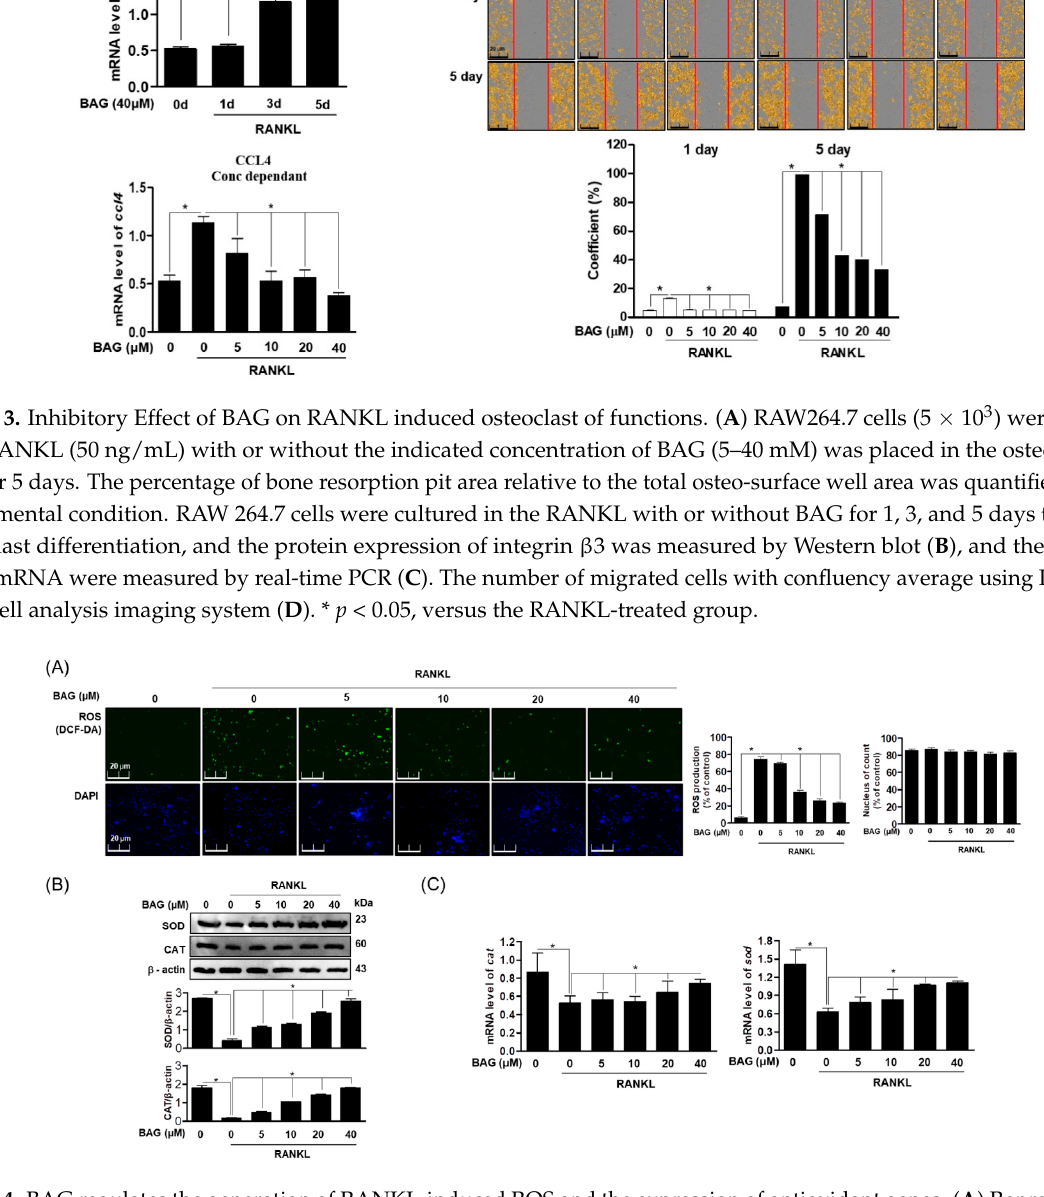
Figure 4. BAG regulates the generation of RANKL-induced ROS and the expression of antioxidant genes. ( A ) Representative stain images of RANKL-induced ROS generation detected by DCFH-DA (green) and immunofluorescence for nuclei using DAPI (blue) in RAW264.7 with different indicated concentrations of BAG. ( B ) The expressions of SOD and CAT antioxidant proteins were analyzed by Western blot analysis from cells pre-treated with BAG and stimulated by RANKL (50 ng/mL). ( C ) The mRNA level of antioxidant genes was measured by real-time PCR. * p < 0.05, versus the RANKL treated group. 2.5. BAG Downregulates RANKL-Induced Expression of Osteospecific Protein and Gene